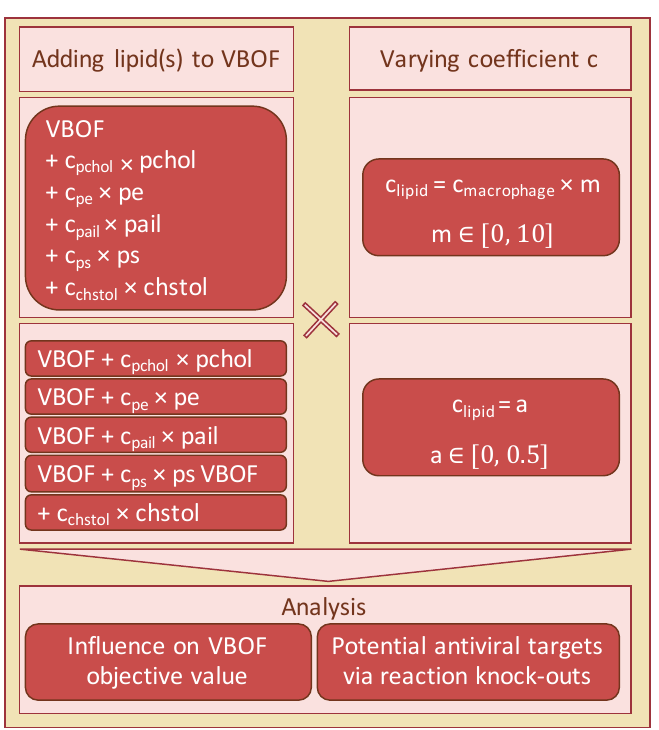
Figure 1. Workflow for the investigation of lipids’ influence on the VBOF. The five lipids phosphatidylcholine (pchol), phosphatidylethanolamine (pe), phosphatidylinositol (pail), phos- phatidylserine (ps), and cholesterol (chstol) were added together and individually to the VBOF. The stoichiometric coefficients were either an absolute value identical for all lipids, or the initial stoichiometric coefficient from the macrophage biomass function factorized with a multiplication- coefficient. For all scenarios, the influence of the different VBOFs on the objective value was analyzed. Additionally, potential antiviral targets were examined using reaction knock-outs.